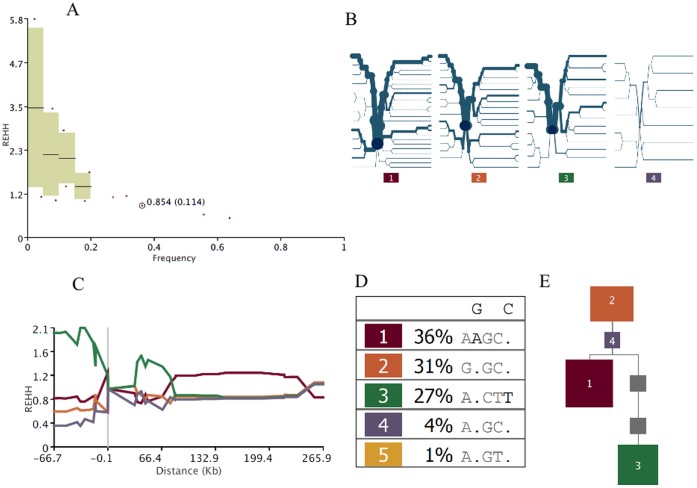
The analysis results based on the early-AFP group are shown.Panel A shows the scatter plot of REHH plotted against all core haplotype frequency (circled dot indicates the selected core haplotype “rs1074014-rs1072877-rs1564582-rs11212724-rs11211725”). Panel B shows the haplotype bifurcation diagram, which visualizes the breakdown of LD at increasing distances from core haplotypes at the selected core region. The root of each diagram is a core haplotype, identified by a dark blue circle. Panel C illustrates how the REHH value varies by the selected core haplotype. Panel D shows the table of core haplotype, and the dot in the observed haplotype sequence represents the allele that matches the ancestral. Panel E presents the theoretical phylogenetic tree of different core haplotypes. Gray squares represent haplotypes that are not present in the observed data, but are missing links in the phylogeny. The area of the squares is proportional to the frequency of the haplotype.